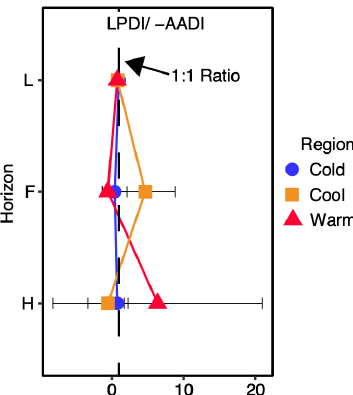
Figure 4. Ratio of the lignin phenol diagenetic index (LPDI) to the inverse sign of the total hydrolysable amino acid diagenetic index ( − AADI) with depth in all regions averaged. Ratios do not change significantly among regions at α = 0 . 05, indicating that the rela- tive rates of lignin and amino acid diagenesis are similar across all regions and with depth. Post hoc tests revealed no significant differ- ence between organic layer depth given as the individual horizons (L, F, and H) and/or site at the regional level. This ratio is